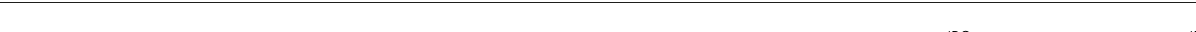
Fig. 7 Inactivation of Flt1 in PDGFR β + cells. a Experimental scheme of tamoxifen administration for the generation of Flt1 iPC mutants. b P6 control, Flt1 iPC/+ and Flt1 iPC retinas stained with isolectin B4 (IB4). Dashed circles indicate vessel-covered (yellow) and peripheral avascular (white) areas in the overview pictures (top). Scale bar, 500 µ m. c Quantitation of body weight and radial outgrowth of the retinal vasculature in control, Flt1 iPC/+ and Flt1 iPC P6 pups. Error bars, s.e.m. p -values, one-way ANOVA. NS, not statistically signi fi cant. d Confocal images of the IB4-stained P6 control, Flt1 iPC/+ and Flt1 iPC retinal angiogenic front illustrating differences in sprout number and morphology. Scale bar, 100 µ m. e Quantitation of sprouts and fi lopodia in P6 control, Flt1 iPC/+ and Flt1 iPC retinas. Error bars, s.e.m. p -values, one-way ANOVA and Tukey ’ s multiple comparison test. NS, not statistically signi fi cant. f Confocal images of IB4 (red), Erg1 (green) and VEGFR2 (white) stained P6 retinas highlighting the accumulation of EC nuclei and enhanced VEGFR2 immunosignals (arrowheads) in Flt1 iPC sprouts. Vessels are outlined by dashed lines on the right panel. Scale bar, 100 µ m. g Quantitation of EC proliferation (EdU+ Erg1+) at the angiogenic front, EC density in sprouts and leading front vessel and VEGFR2 immunosignals intensity in the angiogenic front of control and Flt1 iPC P6 retinas. Error bars, s.e.m. p -values, Student ’ s t -test. h Esm1 (white) expression (arrowheads) in the angiogenic front (IB4+, red, fi rst two columns) and detection of desmin+ pericytes (green, third column) in P6 control and Flt1 iPC retinas. Scale bar, 100 µ m. i Quantitation of Esm1+ proportion relative to vascular area (IB4+) in the angiogenic front of control and Flt1 iPC P6 retinas. Error bars, s.e.m. p -values, Student ’ s t -test. j Confocal images of P6 retinas stained for NG2 (green) and IB4 (red) showing no signi fi cant changes in pericyte coverage in the front ( fi rst two columns) or the remodeling plexus around veins (v) or arteries (a) (last two columns). Scale bar, 100 µ m. k , l Quantitation of pericyte coverage k and relative gene expression by qPCR on whole lysates l in control and Flt1 iPC P6 retinas. Error bars, s.e.m. p -values, Student ’ s t -test. NS, not statistically signi fi